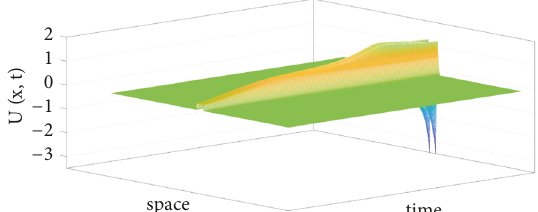
Figure 2: Numerical solution when the positivity and stability condition is broken. Table 1: Relative root mean squared error RRMSE and